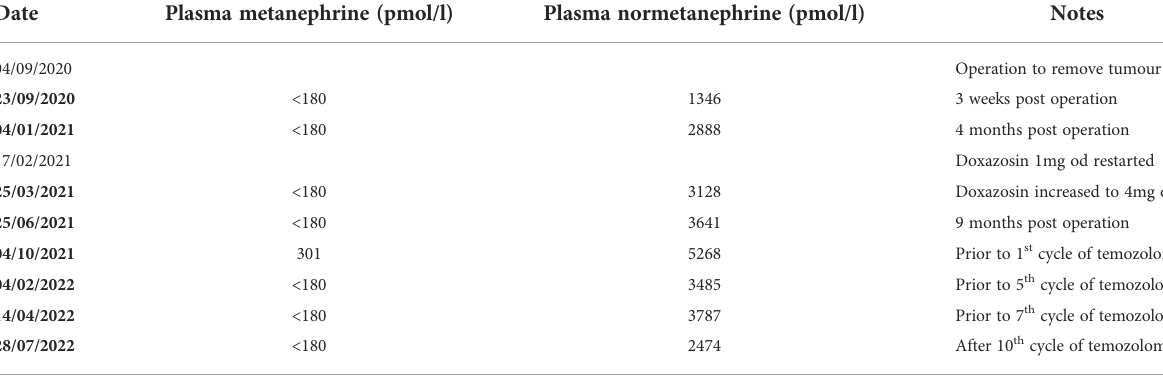
TABLE 1 Table showing concentration of plasma metanephrine and plasma normetanephrine at various timepoints. Plasma metanephrine (pmol/l) Plasma normetanephrine (pmol/l)